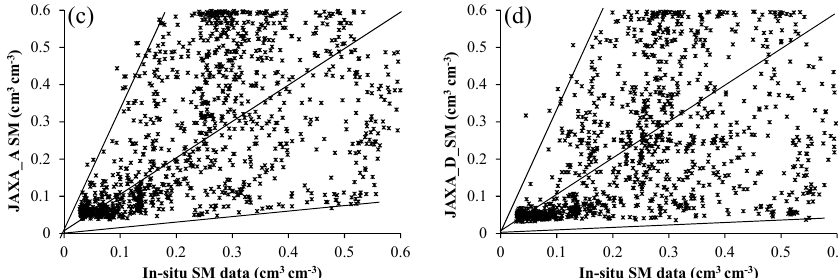
Figure 6. Comparison of AMSR-E / NASA or JAXA SM products with in-situ SM measurements data in 2011: ( a ) AMSR-E / NASA during ascending orbits and ( b ) descending orbits; ( c ) AMSR-E / JAXA during ascending orbits, and ( d ) descending orbits.